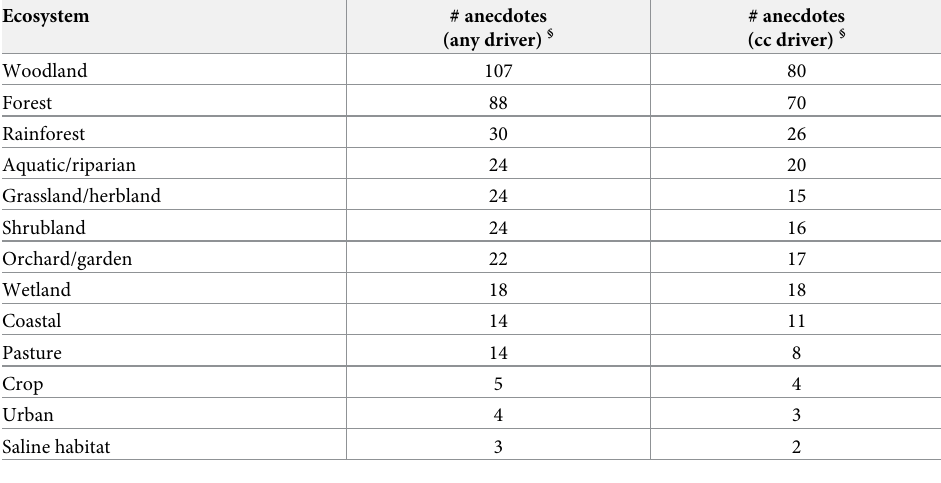
Table 4. Number of anecdotes specifying occurrence of ecological changes in particular ecosystem types. Ecosystem # anecdotes (any driver)